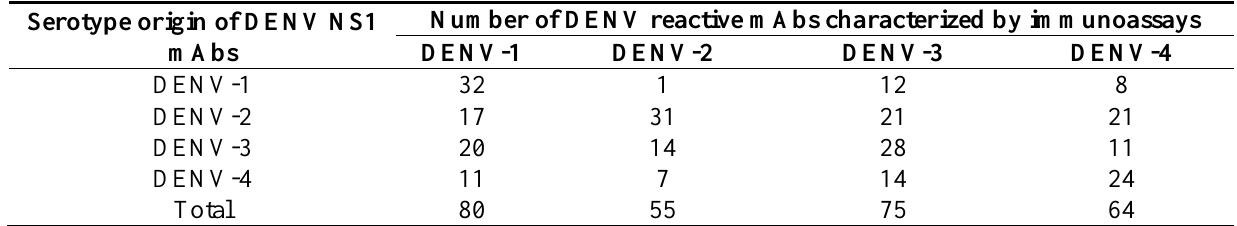
Table 1. Selectivity of dengue virus (DENV) reactive mAbs for each serotype used in this study. Number of DENV reactive mAbs characterized by immunoassays Serotype origin of DENV NS1 mAbs DENV-1 DENV-2 DENV-3